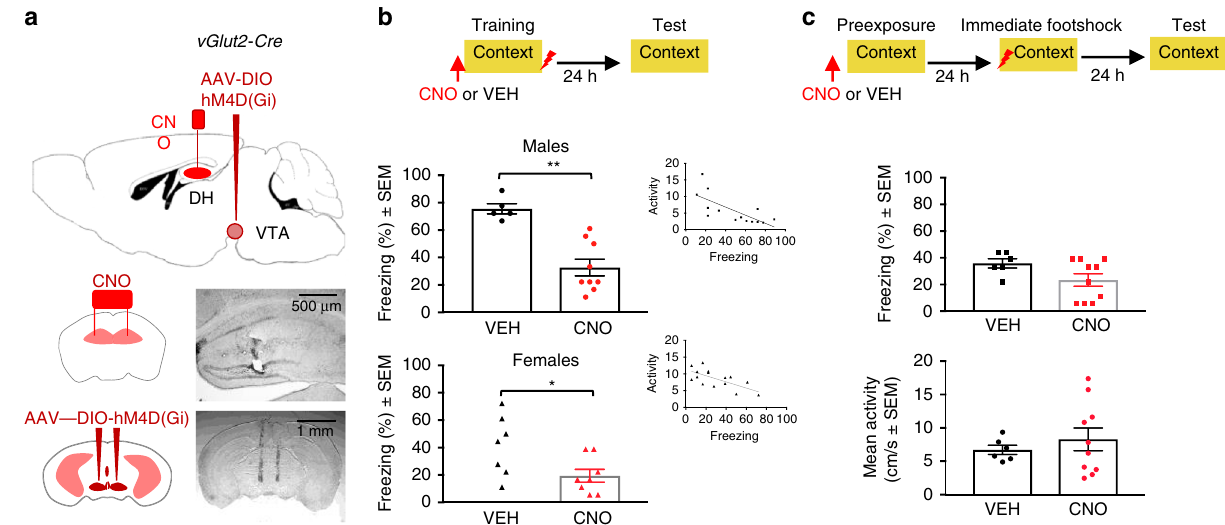
Fig. 2 Chemogenetic inhibition of vGlut2 VTA → DH terminals impairs contextual fear conditioning in male and female mice. a Schematics and histological images demonstrating the cannula placement sites in DH (top and middle) and VTA injection sites of AAV8-DIO-hM4D(Gi) in VTA (top and bottom). b CNO signi fi cantly reduced freezing behavior during the memory test both in males [top, t 12 = 4.886, ** P = 0.004 CNO ( n = 9) vs. VEH ( n = 5) groups] and females [bottom, t 13 = 2.367, * P = 0.0341, CNO ( n = 7) vs. VEH ( n = 8) groups] (right), as determined with two-tailed unpaired t test. Inset shows correlations between freezing scores and mean activity detected automatically by an infrared beam system (males, r = − 0.7201, P = 0.0037, females, r = − 0.6791, P = 0.0054). c CNO ( n = 10) injected before context pre-exposure in the CPFE paradigm, did not affect freezing ( t 15 = 2.096, P = 0.0830, top) or locomotor activity ( t 15 = 0.6706, P = 0.5005, bottom) relative to VEH ( n = 6), as determined with two-tailed unpaired t